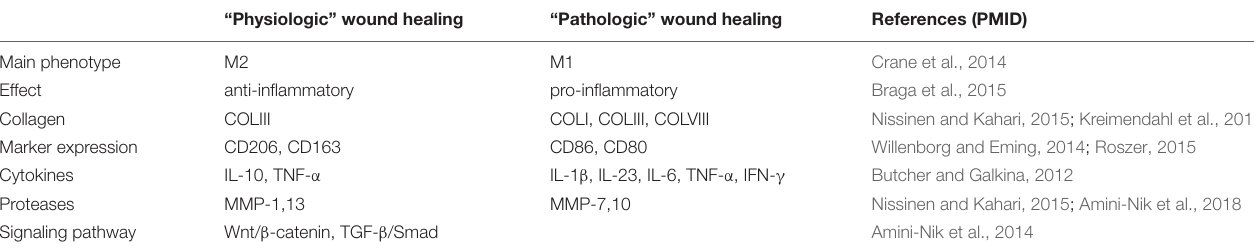
TABLE 1 | The role of macrophages and related factors in wound healing.